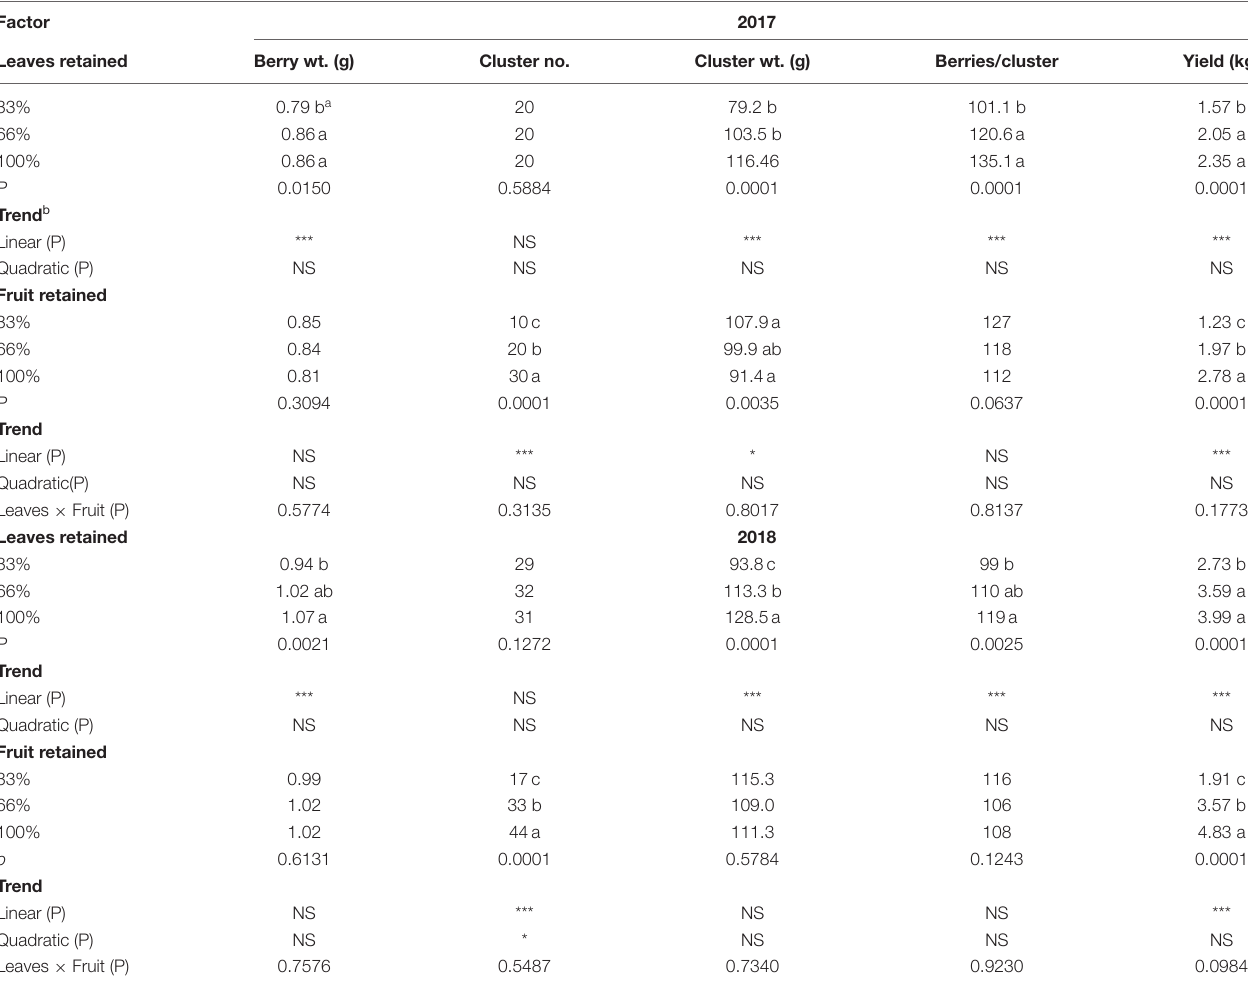
TABLE 1 | Effects defoliation and fruit removal on components of yield on Cabernet Sauvignon/110R in two successive seasons (2017–2018).